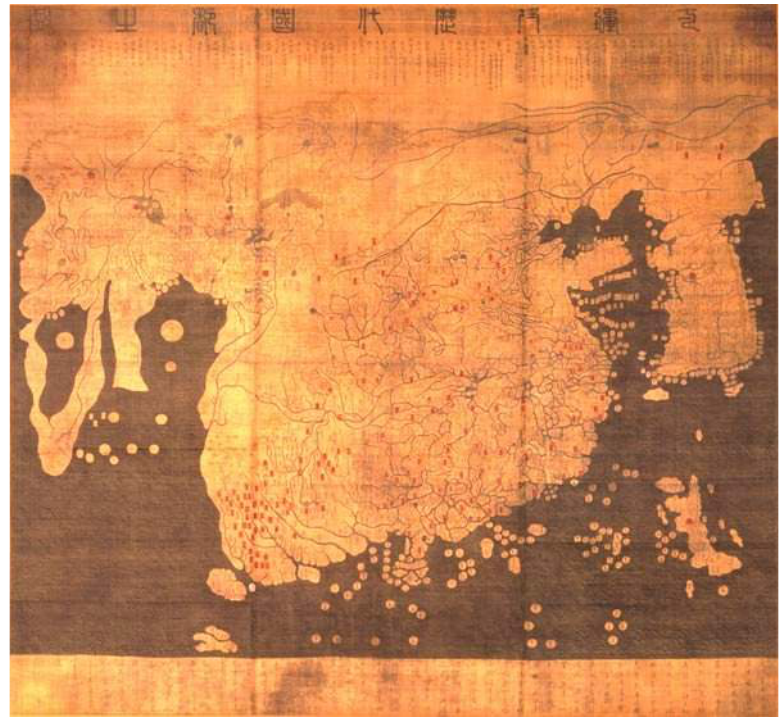
Figure 3. The Kangnido Map